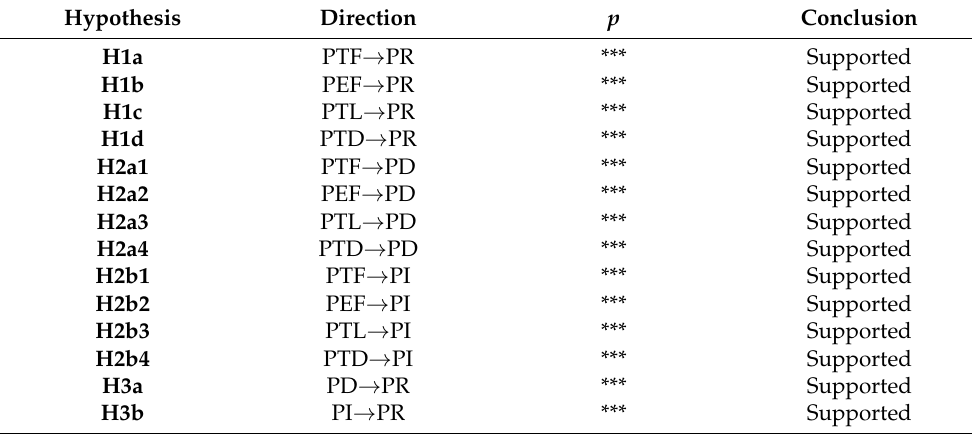
Table 4. Tests for mediation effects.